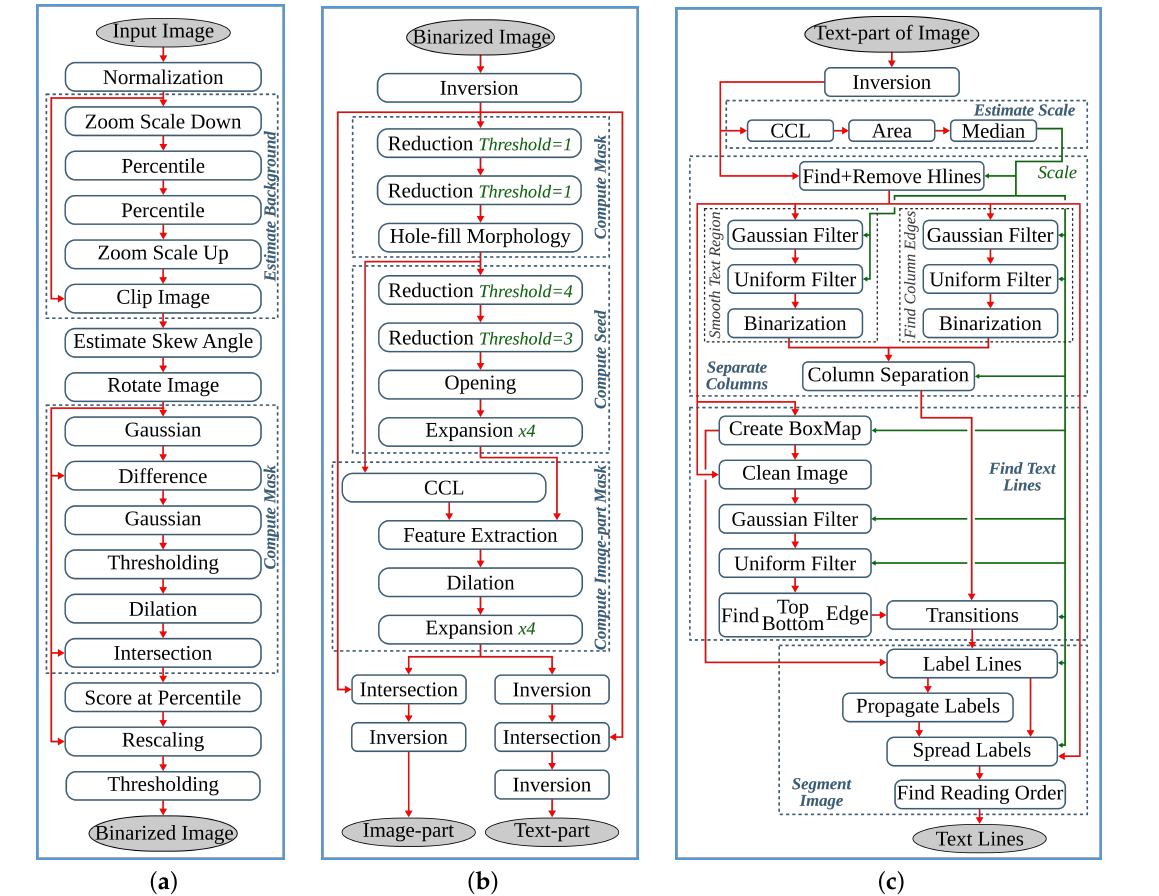
Figure 2. Algorithms of the three anyOCR preprocessing steps: ( a ) Binarization, ( b ) Text and Image Segmentation, and ( c ) Text-line